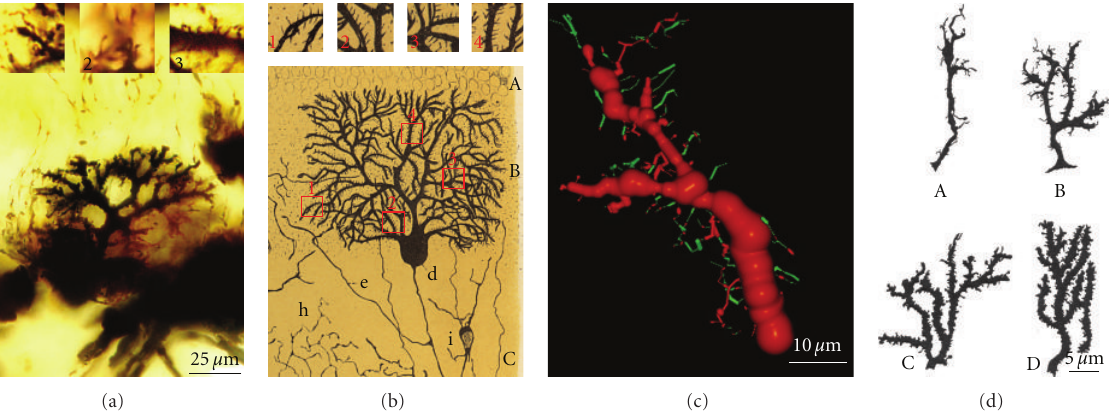
Figure 10: (a) Shows Purkinje cell forming the dendritic branchlets, Cajal histological preparation, Golgi method, newborn cat. Insets: 1, terminal filopodia; 2, thin dendritic spines; and 3, dendritic spines contacting climbing fibers. (b) Purkinje cell, 15-day-old cat. Insets show filopodia and thin dendritic spines, Cajal scientific drawing [23, Figure 2]. (c) Purkinje cell, apical branch, three-dimensional reconstruction showing dendritic filopodia and protospines (green) and few dendritic spines (red), newborn cat. (d) Purkinje cell, dendritic filopodia, protospines and dendritic spines, rat of 5 days (A), 10 days (B), 15 days (C), and 30 days (D); scientific drawing of Berry and Bradley